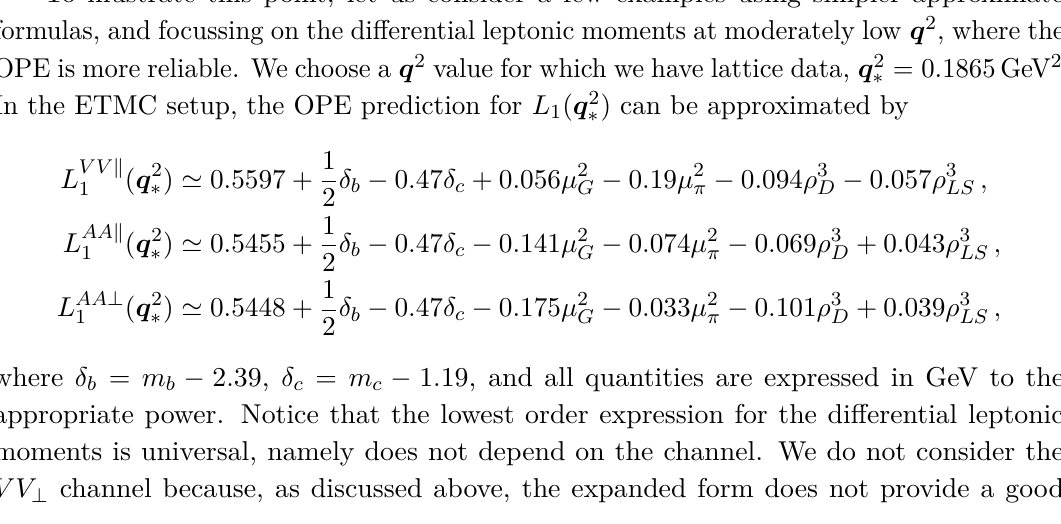
Figure 21 . Differential moment H 1 ( q 2 ) = h M 2 comparison between OPE and JLQCD